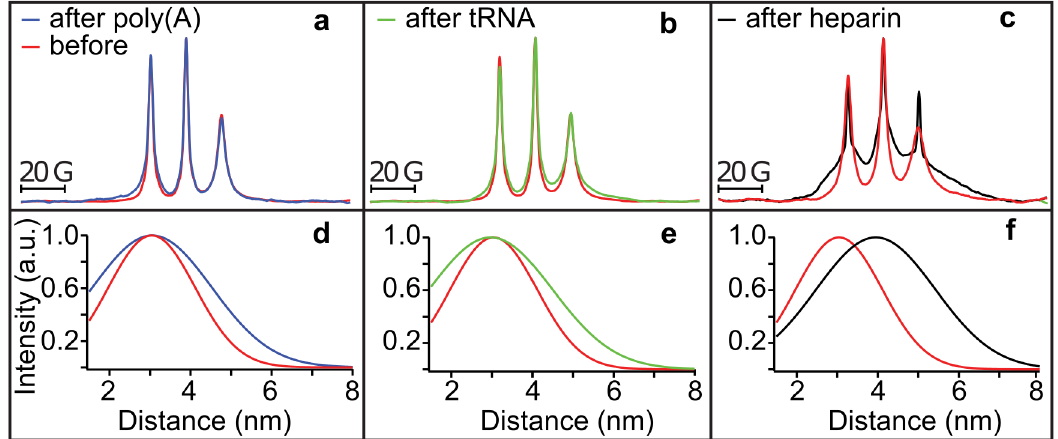
Fig 6. Tau in condensed droplets assumessolution state properties. (A-C) Continuous wave electron paramagnetic resonance (cw EPR) spectra obtainedat room temperature of 500 μ M Δ tau187-SL in dropletsformed with 1.5 mg/ml poly (A) RNA (blue in A) and 1.5 mg/ml tRNA (green in B) is unalteredfrom solutionbefore addingRNA (red in A and B). Cw EPR line shape upon adding125 μ M heparin(black in C) show dramatic line broadening(comparedto red in C). Double electron-electron resonance (DEER) of Δ tau187-SL 2 in droplets formed with 1.5 mg/ml poly(A) RNA (blue in D) and 1.5 mg/ml tRNA (green in E), as well as uponincubationwith 137.5 μ M heparin(black in F) comparedto Δ tau187-SL 2 in solution(red in D-F). The numerical data are includedin S1